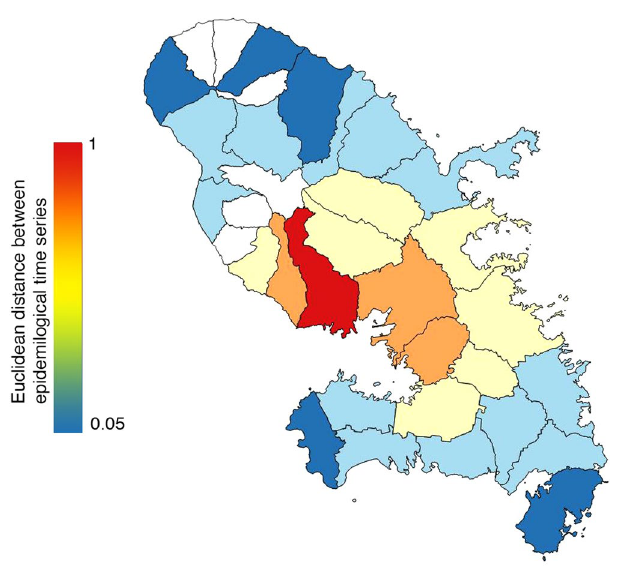
Figure 2. Invasion sequence of the Chikungunya outbreak based on similarity of epidemiological dynamics between each locality and Fort-de-France (similarity has been quantified through Euclidean distance between time series, see main text for more details). Colors follow a gradient from red (considered as epicenter of the epidemics, Fort-de-France, with therefore a correlation of 1) to dark blue (last localities to have been affected, with a correlation close to 0), representing this similarity (localities in white have no epidemiological data). The map has been generated with R software 28